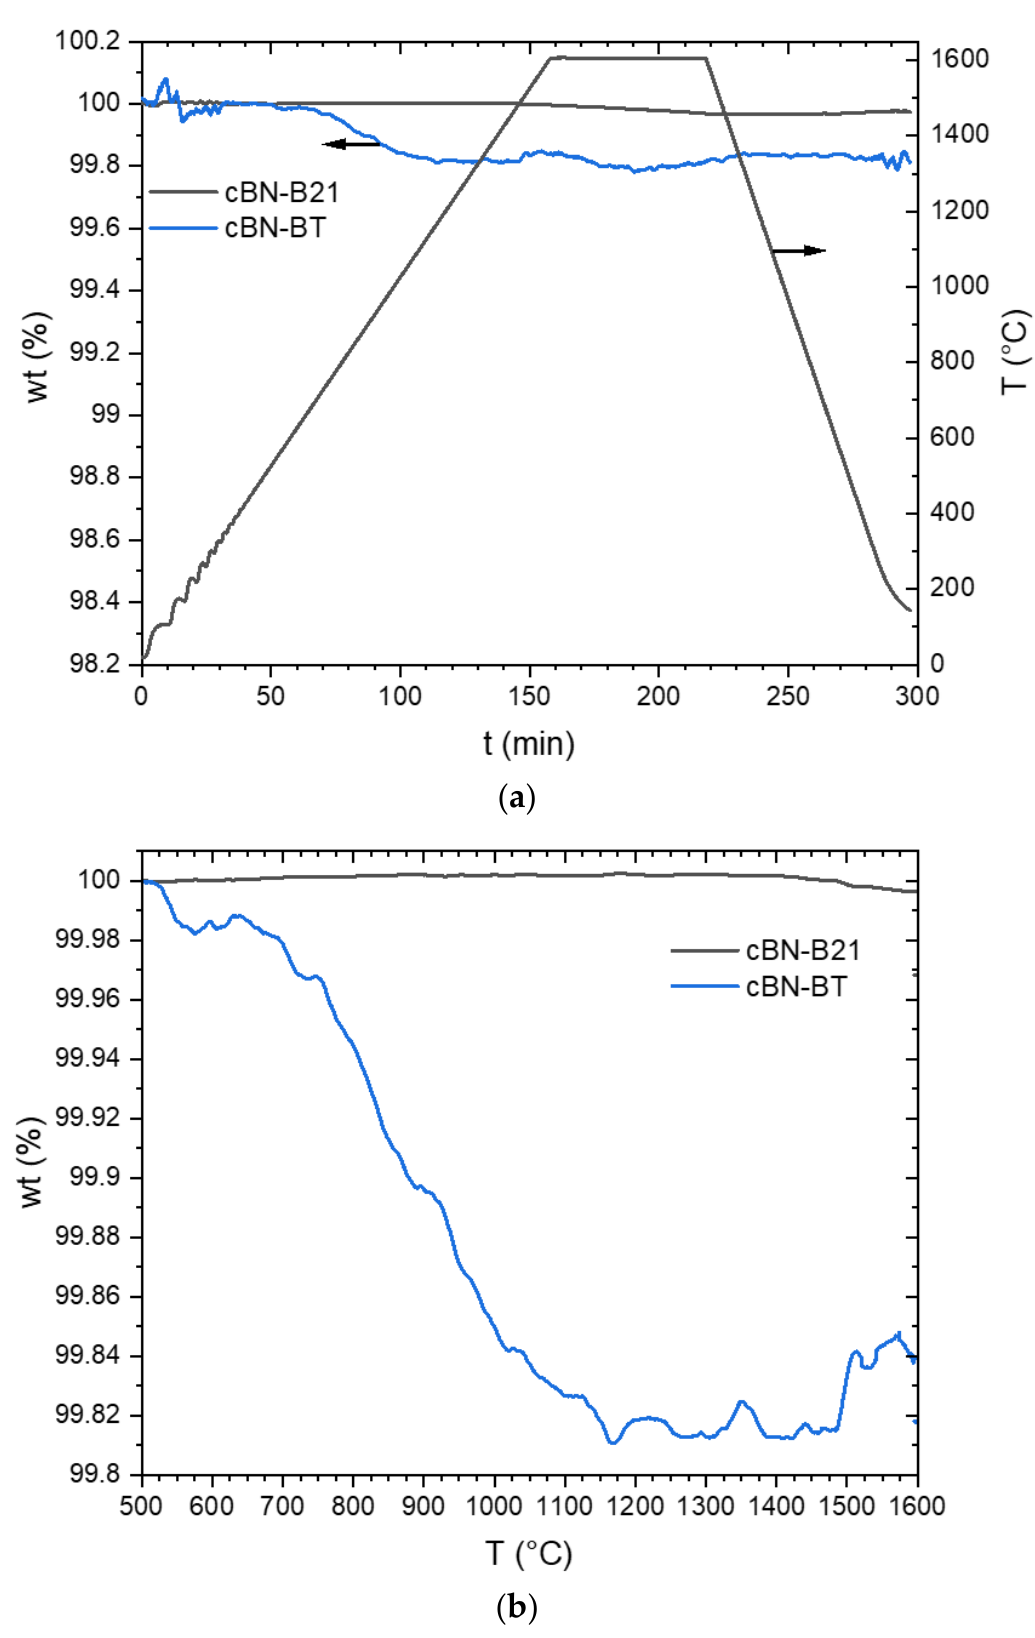
Figure 6. ( a ) Mass loss during thermogravimetric analysis under a nitrogen atmosphere of the cBN powders B21 und BT and ( b ) mass loss as a function of temperature of the same. Table 2. Mass losses of the cBN-powders after thermogravimetric analysis under argon and nitro- gen atmosphere up to a temperature of 1600 °C.